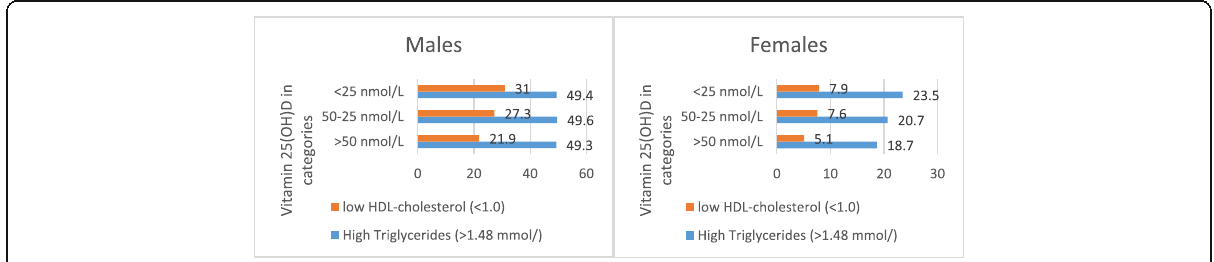
Fig. 1 The percentage of male and female participants with dyslipidemia by vitamin D levels in Riyadh Saudi